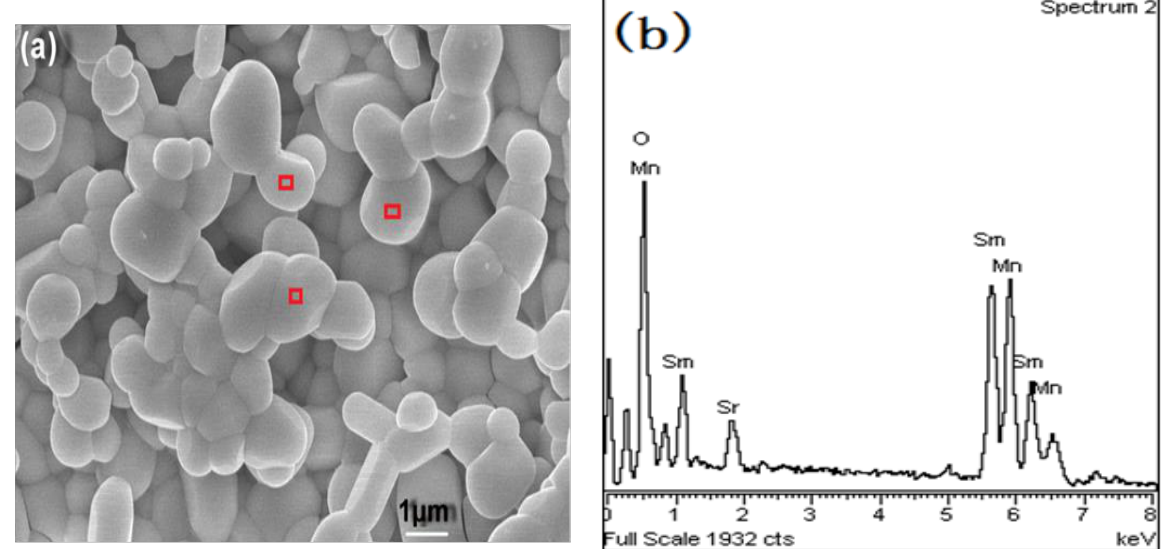
Figure 2. ( a ) SEM image of the ceramic Sm 0.85 Sr 0.15 MnO 3- δ ; ( b ) EDS spectrum corresponding to the SEM image. Table 1. Atomic ratio of Sm, Sr, Mn, and O in Sm 0.85 Sr 0.15 MnO 3- δ by EDS.